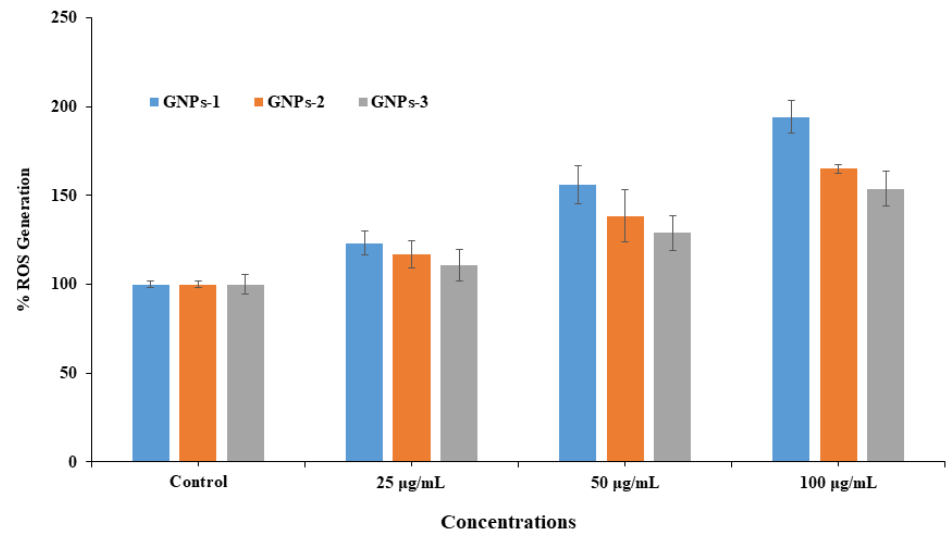
Figure 7. Bar diagram showing percentage change in ROS generation in HepG2 cells exposed to 25 – 100 μg/mL of GNPs -1, GNP-2, and